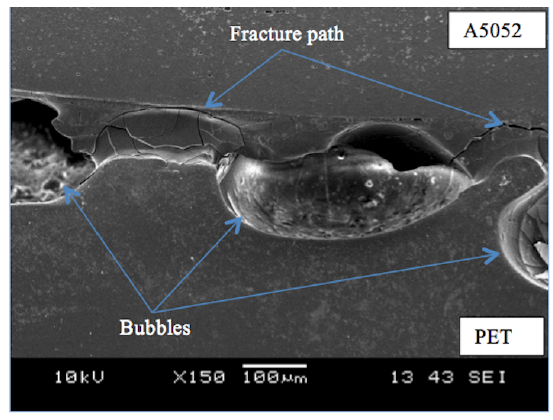
Figure 5. SEM photograph showing fracture path propagated at the bubbles.